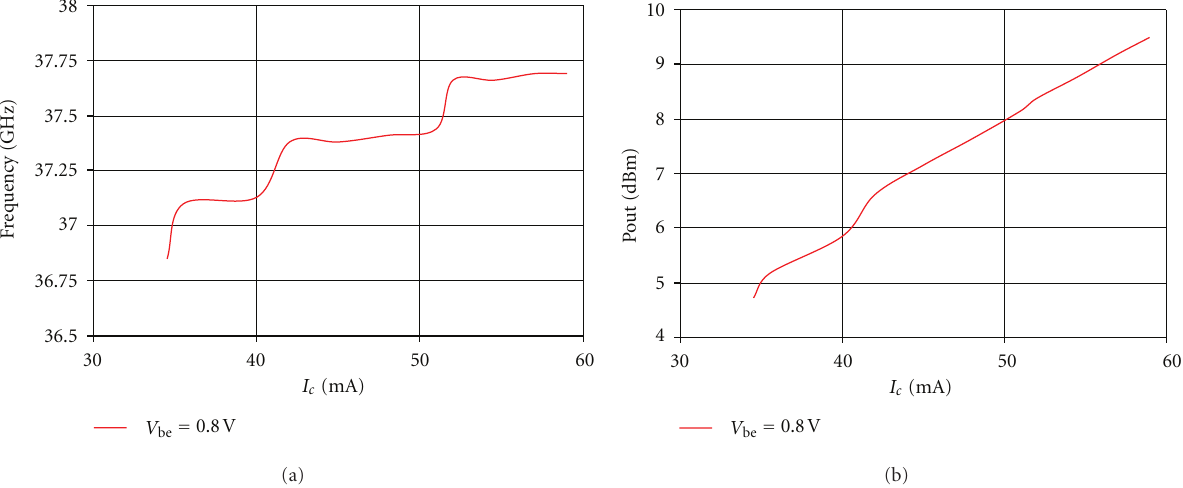
Figure 22: Measurement result of oscillation frequency and output power versus I c current for V be